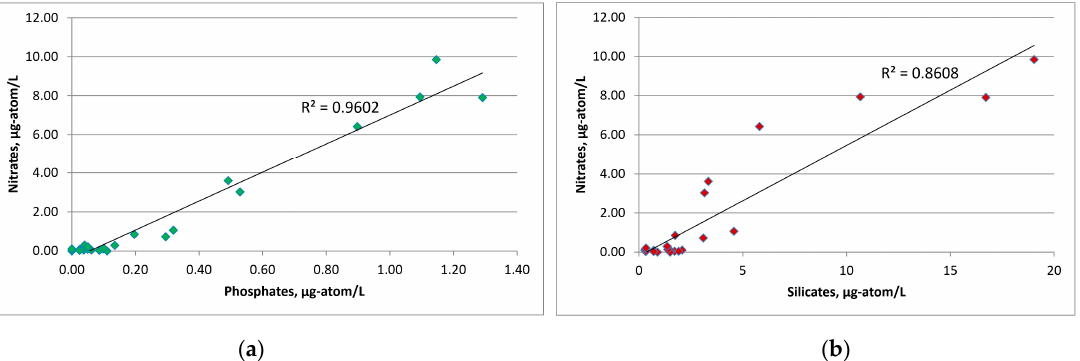
Figure 5. Graphs of the dependence of nitrates on phosphates ( a ) and nitrates on silicates ( b ) over the entire water area under investigation.